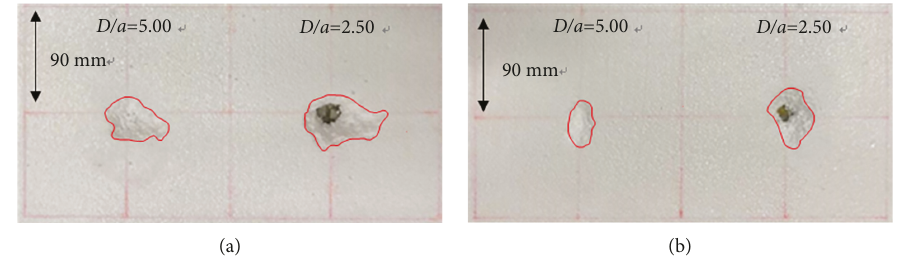
Figure 18: Cleaning effect. (a) d